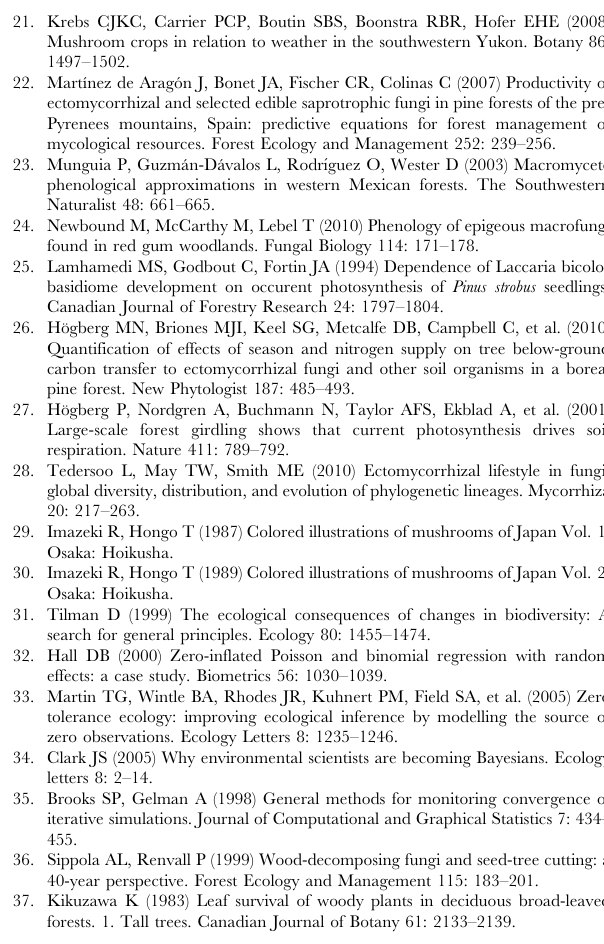
Table S1 Climatic information of each collection date. (DOC) Table S2 A list of observed species at each survey. The nutritional guilds, including ectomycorrhizal fungi (ECM), litter- decomposing fungi (L), and wood-decomposing fungi (W) were identified for fungal species in which species-level identification could be performed. NA represents the nutritional guild of the fungus is not classified into these three guilds. Text S1 BUGS code used in this